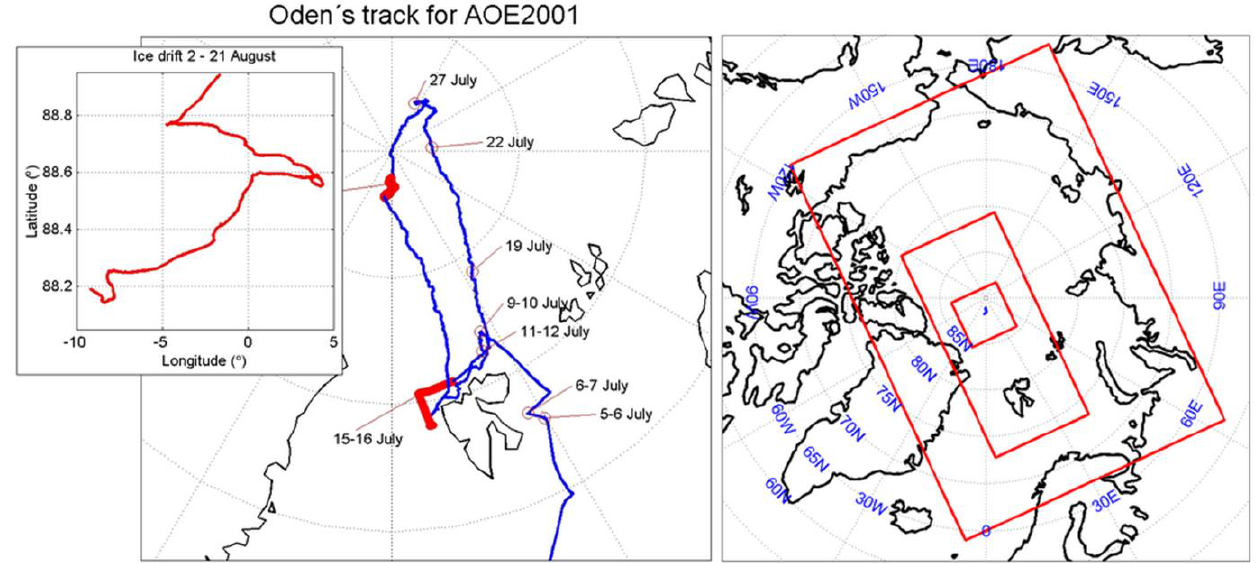
Figure 1. Cruise track for the AOE-2001 expedition (left) showing the whole cruise and as an insert the track for the ice drift and model domain (right) used for the AOE-2001 simulations. The three boxes show the outer model domain and the two nested grids used in the model simulations; the ice-drift track is marked with